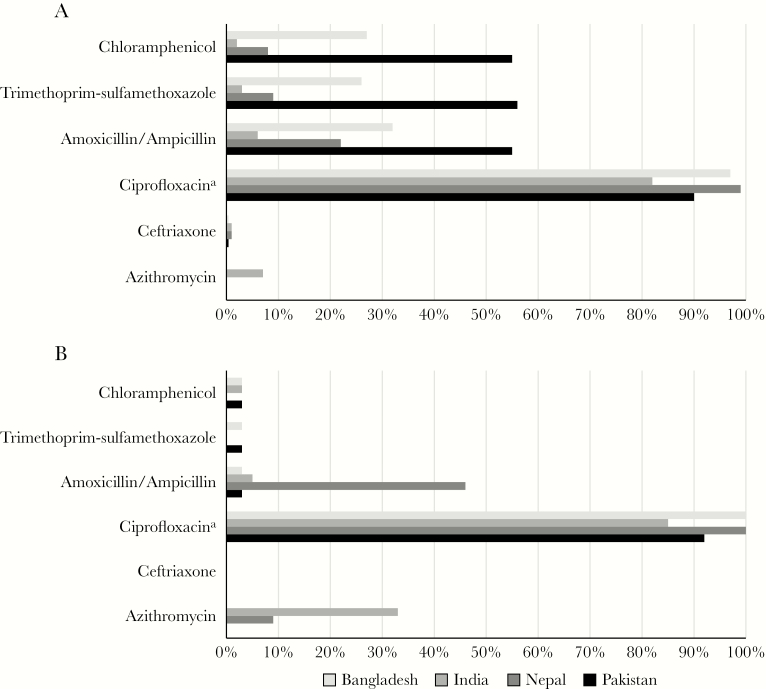
Antimicrobial resistance patterns among Salmonella enterica subspecies enterica serovars Typhi (A) and Paratyphi (B) isolates in Bangladesh, India, Nepal, and Pakistan, Surveillance for Enteric Fever in Asia Project (SEAP) Phase I, 2012–2016. aReduced susceptibility; nalidixic acid was used as a proxy in Bangladesh.